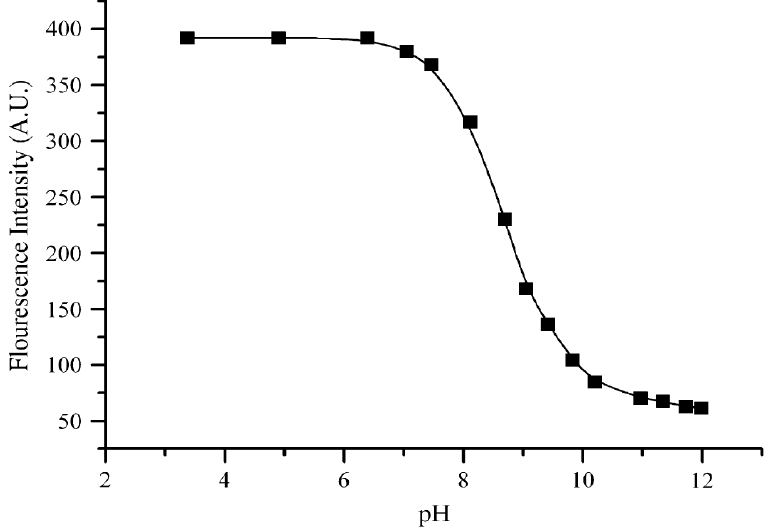
= 370 nm) of 1,2,2,6,6-pentamethyl-piperidin-4- Figure 2. Effect of pH on fluorescence intensity ( λ ex ol. Reprinted from [41] © 2007 with permission from